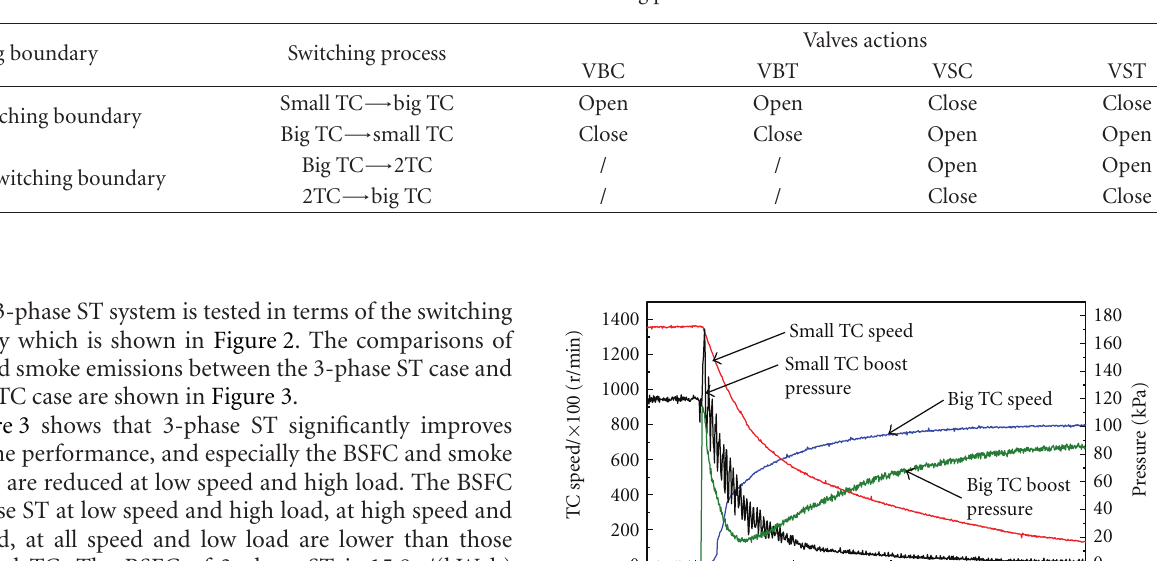
Table 2: Valves actions in switching processes.